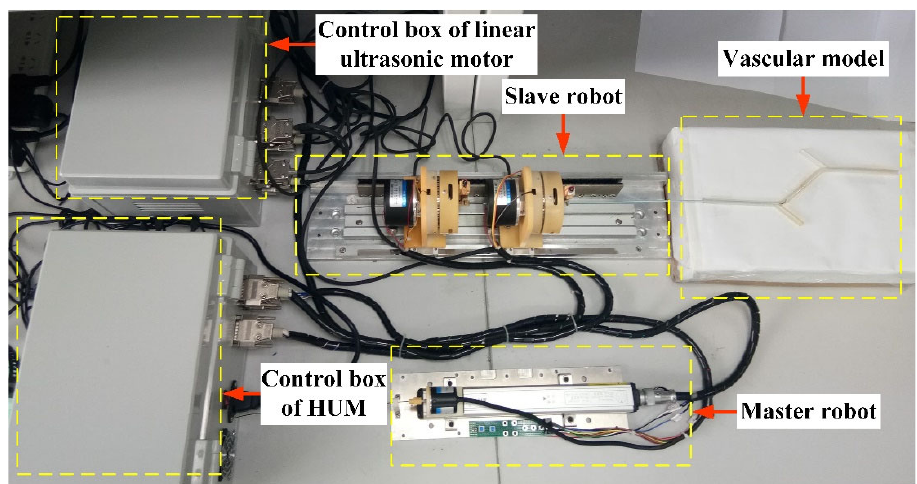
Figure 8. Experimental platform for testing RVIR performance.